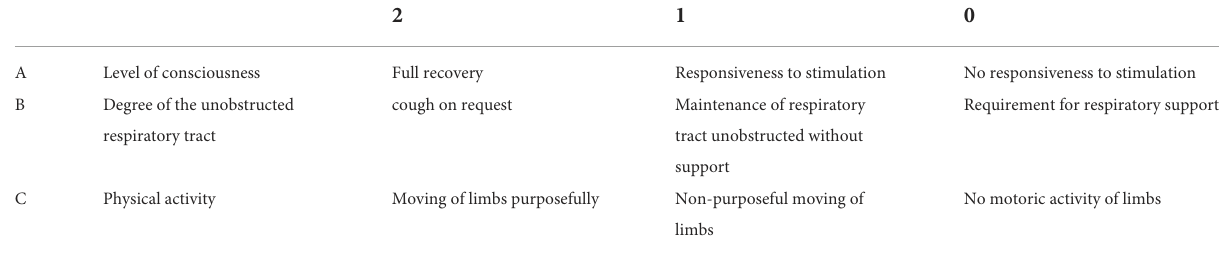
TABLE 1 Steward awakening score scale.